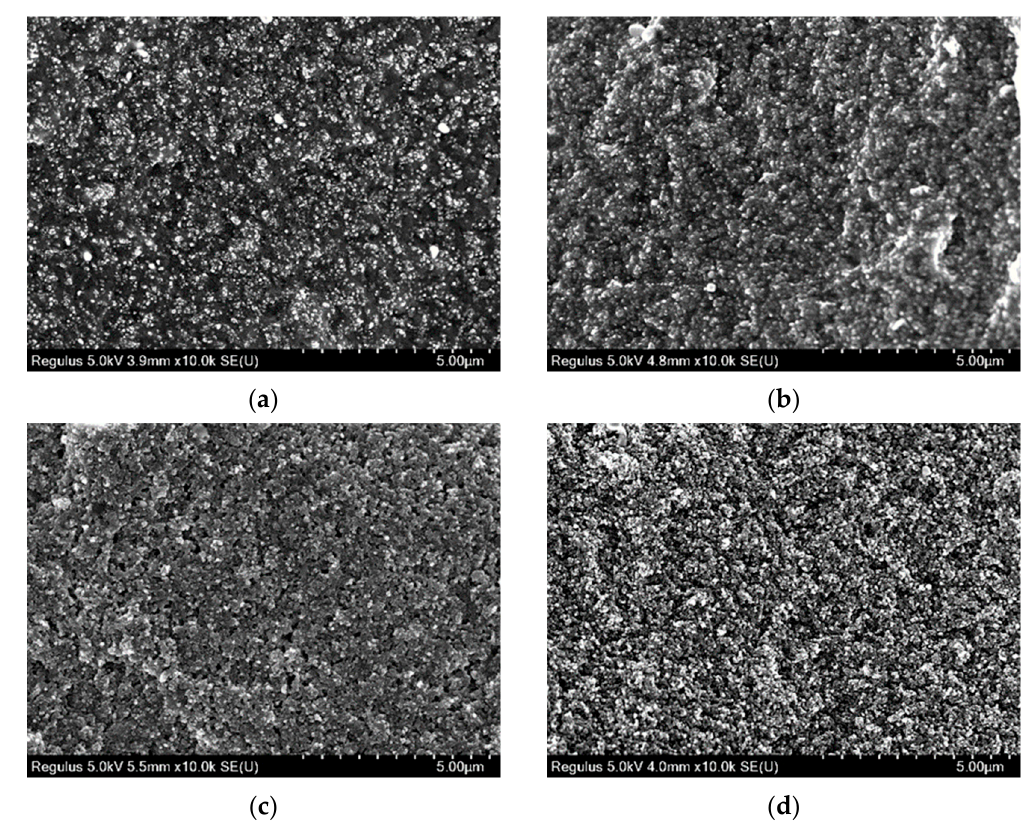
Figure 11. SEM images of SBR section specimen (CB 90–150 phr, magnification 10,000×). ( a ) EG 1– Figure 90 phr; ( b ) EG 1–110 phr; ( c ) EG 1–130 phr; ( d ) EG 1–150 phr.